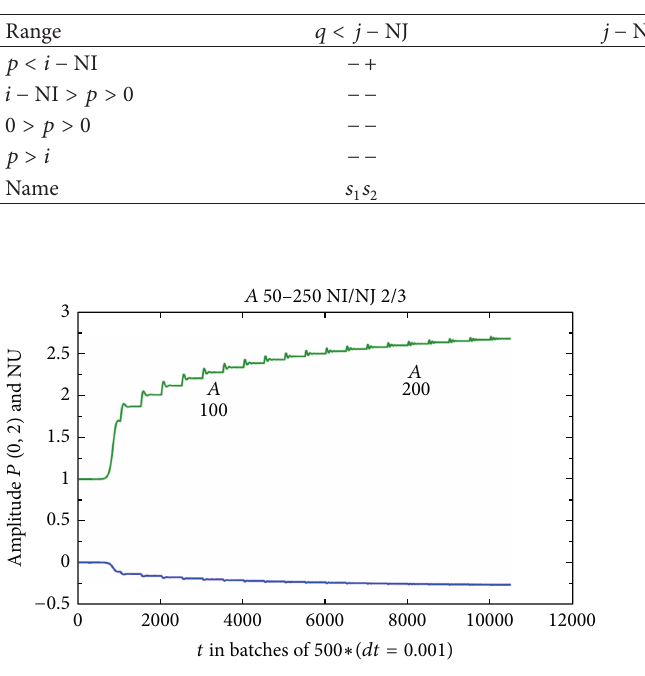
Figure 1: Simulations using NI = 2 and NJ = 3 showing oscillating approach to the stable asymptotes of Nu and 𝑃(0,2) .